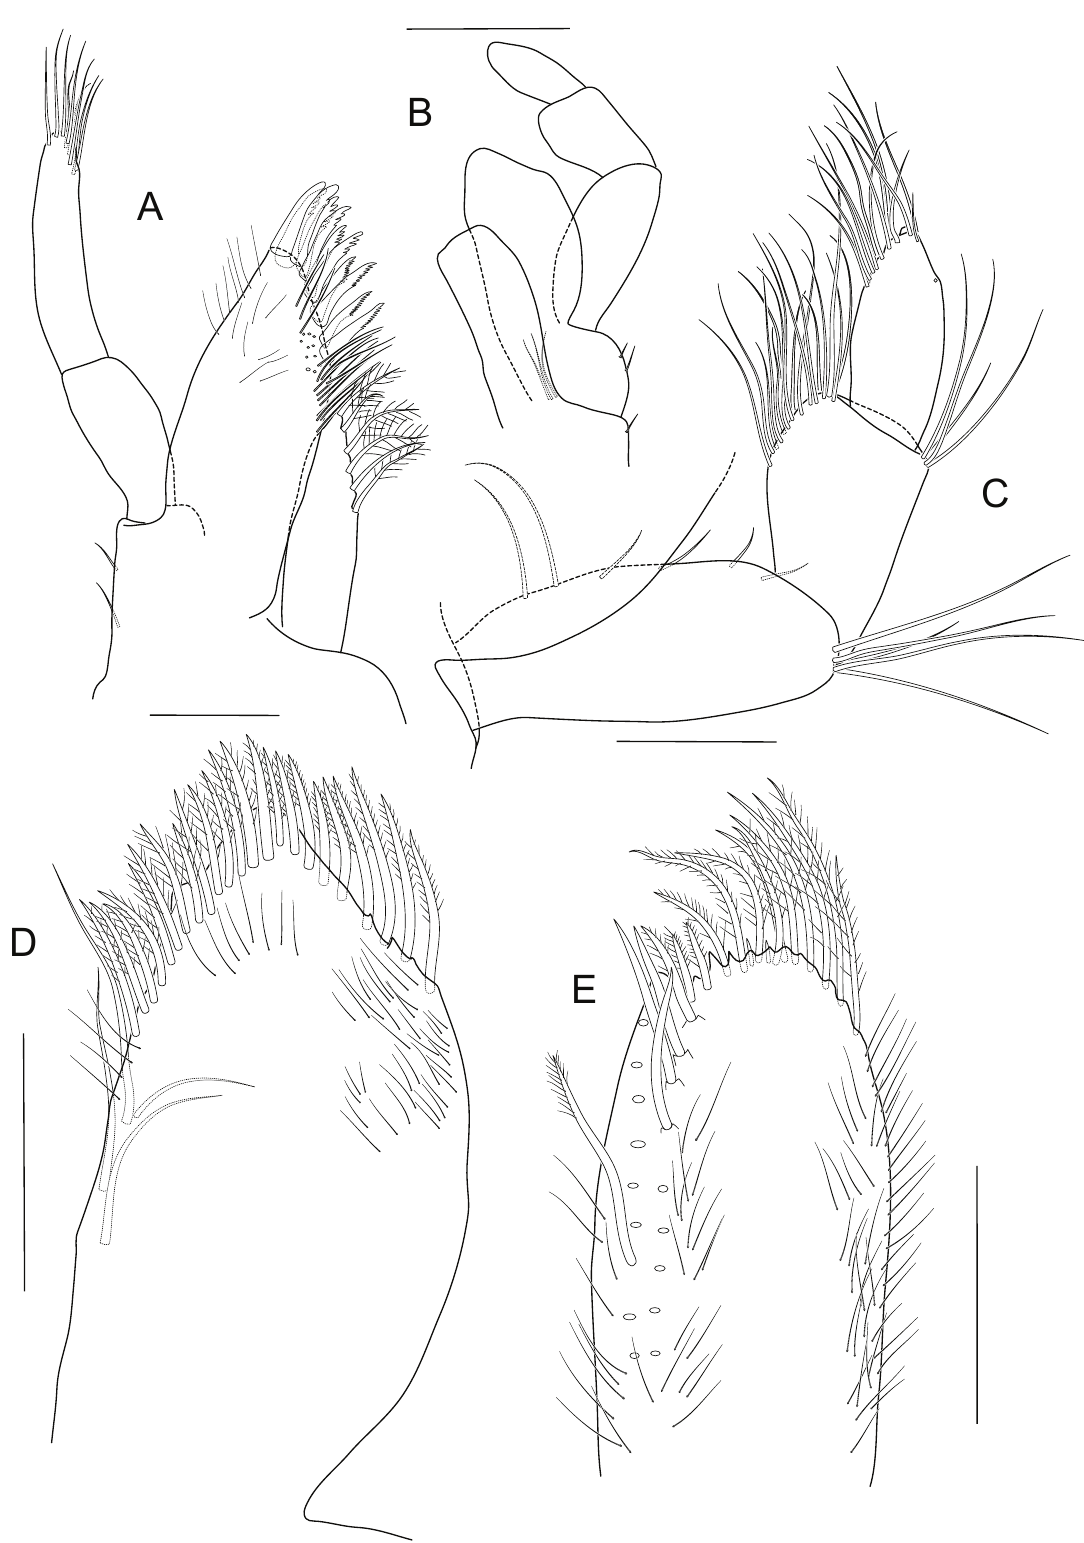
Fig. 3. Labriphimedia meikae nov. sp., holotype ♂, 6 mm, NIWA 84598. A . maxilla 1. B . Outlines of maxilliped. C . Palp of maxilliped. D . Outer plate of maxilliped. E . Inner plate of maxilliped. Scale bars: a, C-e = 100 µm, B = 200